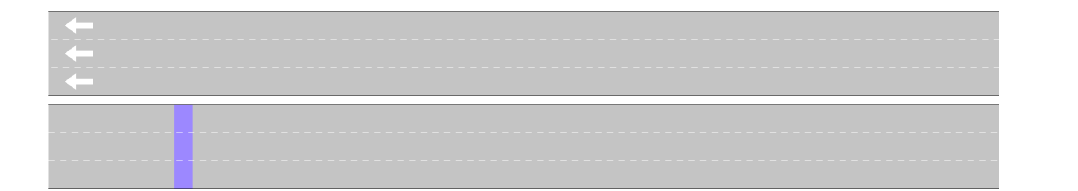
Figure 6. An enlarged version of the 0-Intersection model, representing an uninterrupted motorway with a detector spanning all lanes (purple).